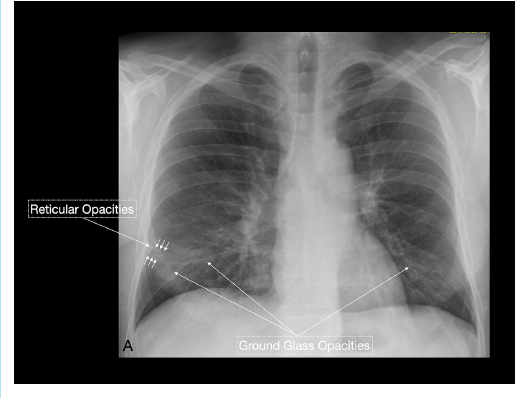
Figure 6 A: A 54-year-old patient being treated for lymphoma re- turned from a US vacation and presented to the emergency de- partment with myalgia, arthralgia, sore throat and pleuritc chest pain, but without fever or cough. Laboratory work revealed elevat- ed C-reactive protein and D-dimer; a baseline RT-PCR test was negative for COVID-19. Chest x-ray (A) demonstrated subtle ground glass and reticular opacities. Clinical suspicion of COVID-19 persisted despite two consecutive negative nasopha- ryngeal swab TR-PCT